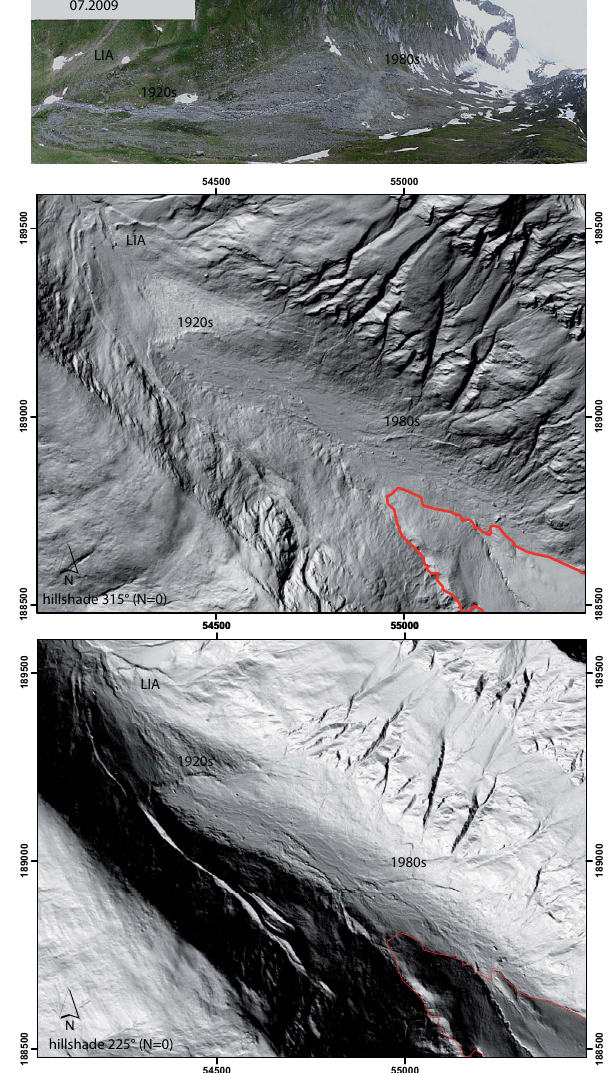
Figure 7. Periglacial area of Gaißbergferner with moraines dating from LIA, 1920 and 1980 (position of the subset: see Fig.